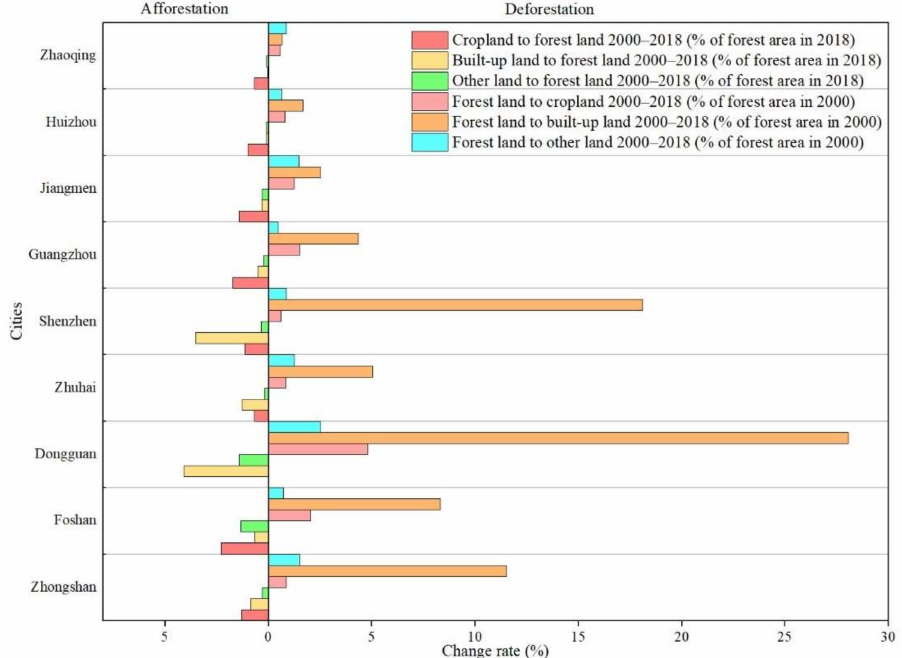
Figure 3. The estimated transformation between forest land to cropland, built-up land, and other lands from 2000 to 2018 among